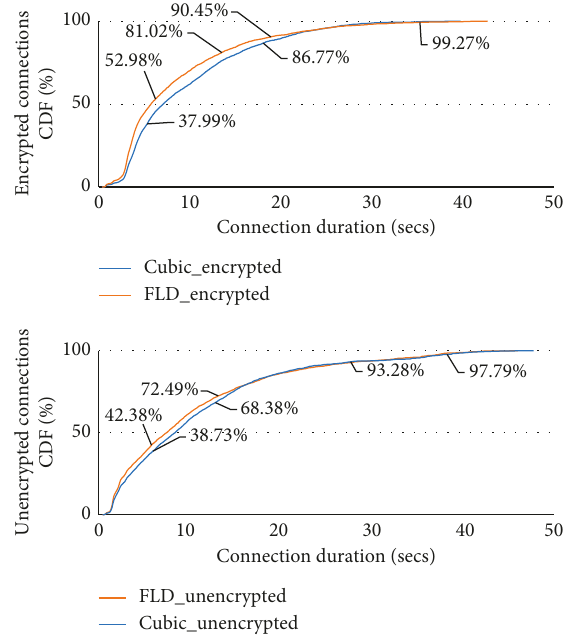
Figure 9: Distribution of connection duration across encrypted and unencrypted connections.